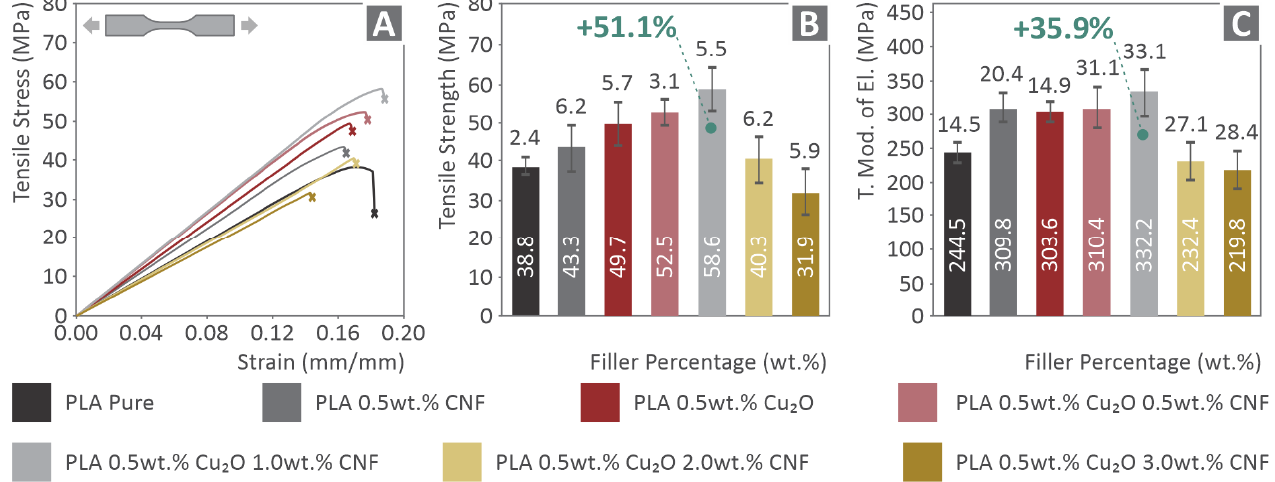
Figure 7. For all materials tested: ( A ) tensile stress vs. strain graph, ( B ) tensile strength and deviation (five specimens were tested), ( C ) tensile modulus of elasticity and deviation (five specimens were tested).